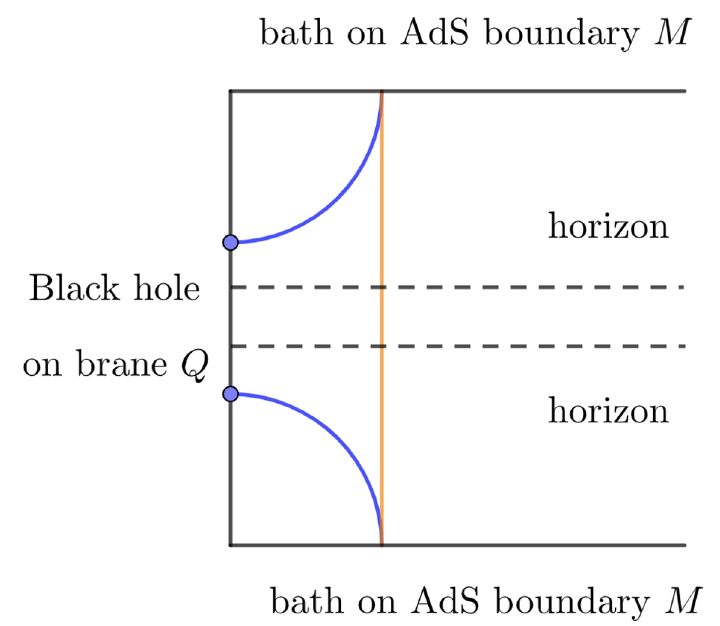
Figure 6 . Doubly holographic setup (space-like slice): black hole lives on the end-of-the-world brane Q ( x = 0 ), and bath lives on the AdS boundary M ( z = 0 ). The dotted line denotes the horizon of black hole, the blue point labels the location of island outside horizon. There are two kinds of extremal surfaces in the bulk. The orange extremal surface passing through the horizon depends on time and is dominant at early times. See figure 7. The blue extremal surface ending on the brane is time-independent and is dominant at late times. It is the so-called